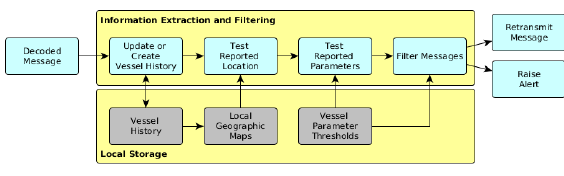
Figure 3. Flow chart of AIS message filtering and history